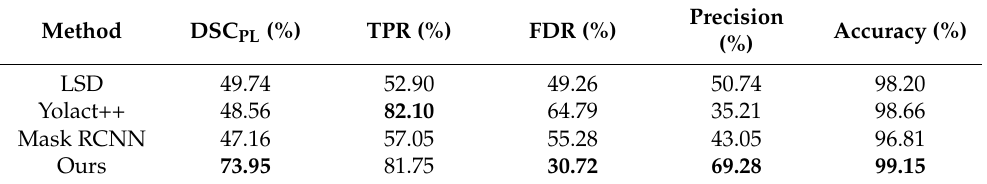
Table 3. Comparison of the performance of each of the four methods on the test